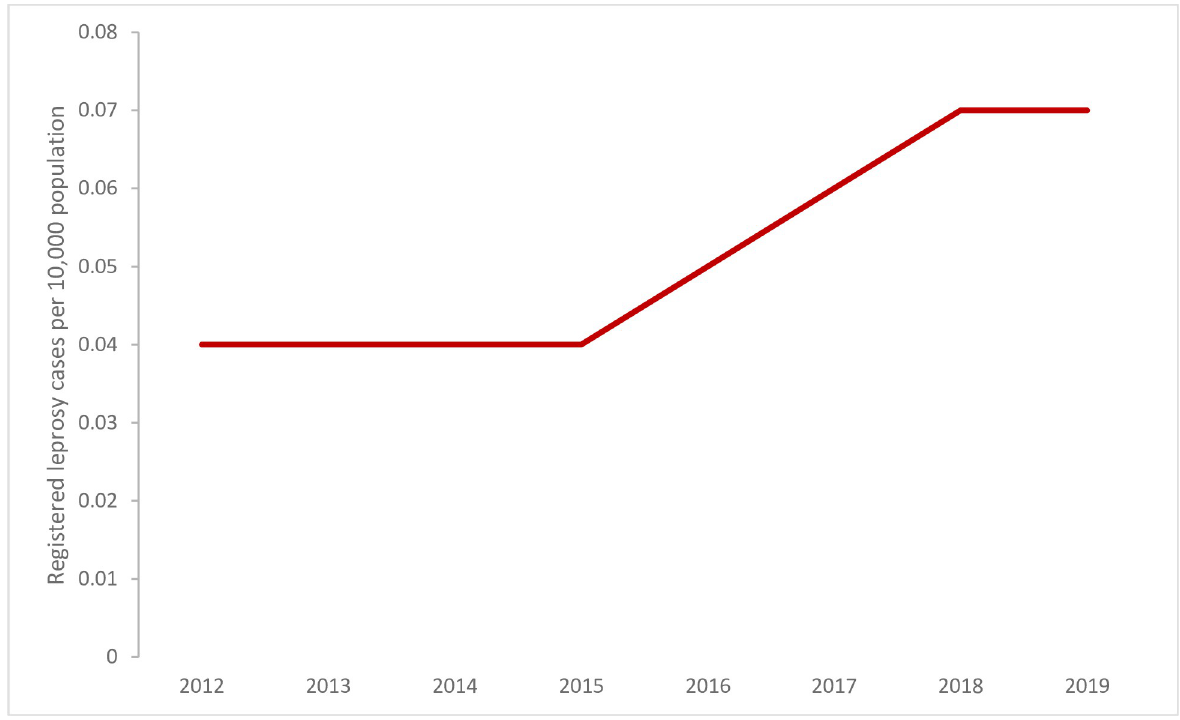
Fig 1. The number of leprosy cases registered for treatment per 10,000 population (prevalence) in the Eastern Mediterranean Region, 2012– 2019, Global Health Observatory data repository